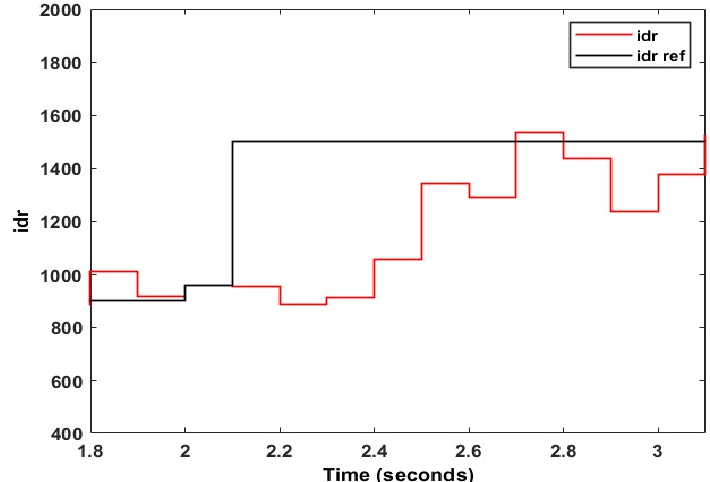
Figure 32. Rotor direct axis current average using LQR at 70% dip.